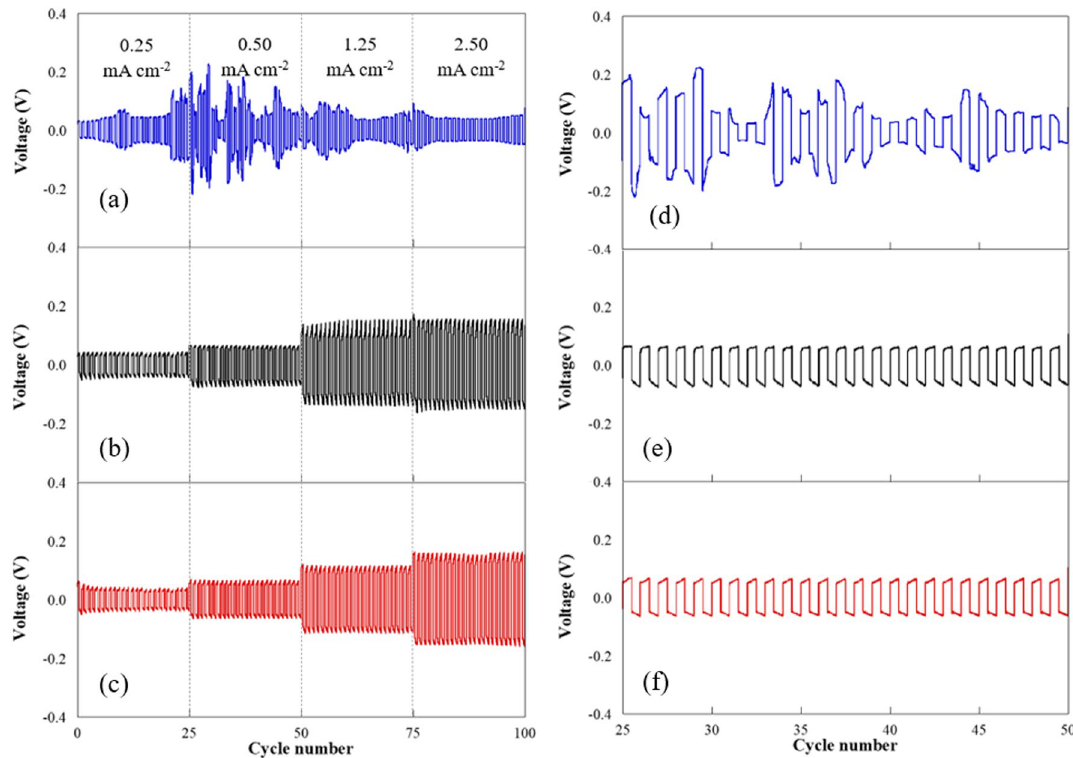
Figure 9. Zn symmetry cell testing for charge/discharges cycle of ( a ) glass fiber separator, ( b ) PAN/bio-based PU without MXene, and ( c ) PAN/bio-based PU/5 wt% MXene; voltage profile in 25 to 50 cycles of ( d ) glass fiber separator, ( e ) PAN/bio-based PU without MXene, and ( f ) PAN/bio-based PU/5 wt%